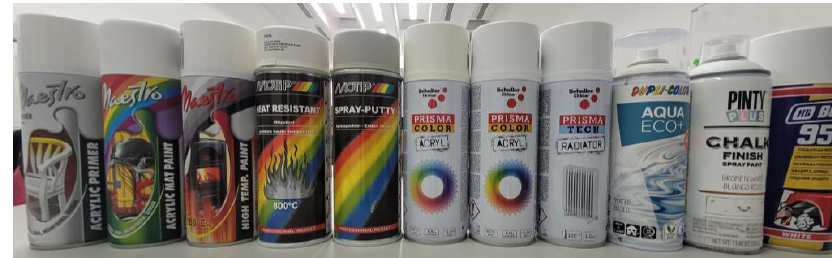
Figure 5. The applied paints.